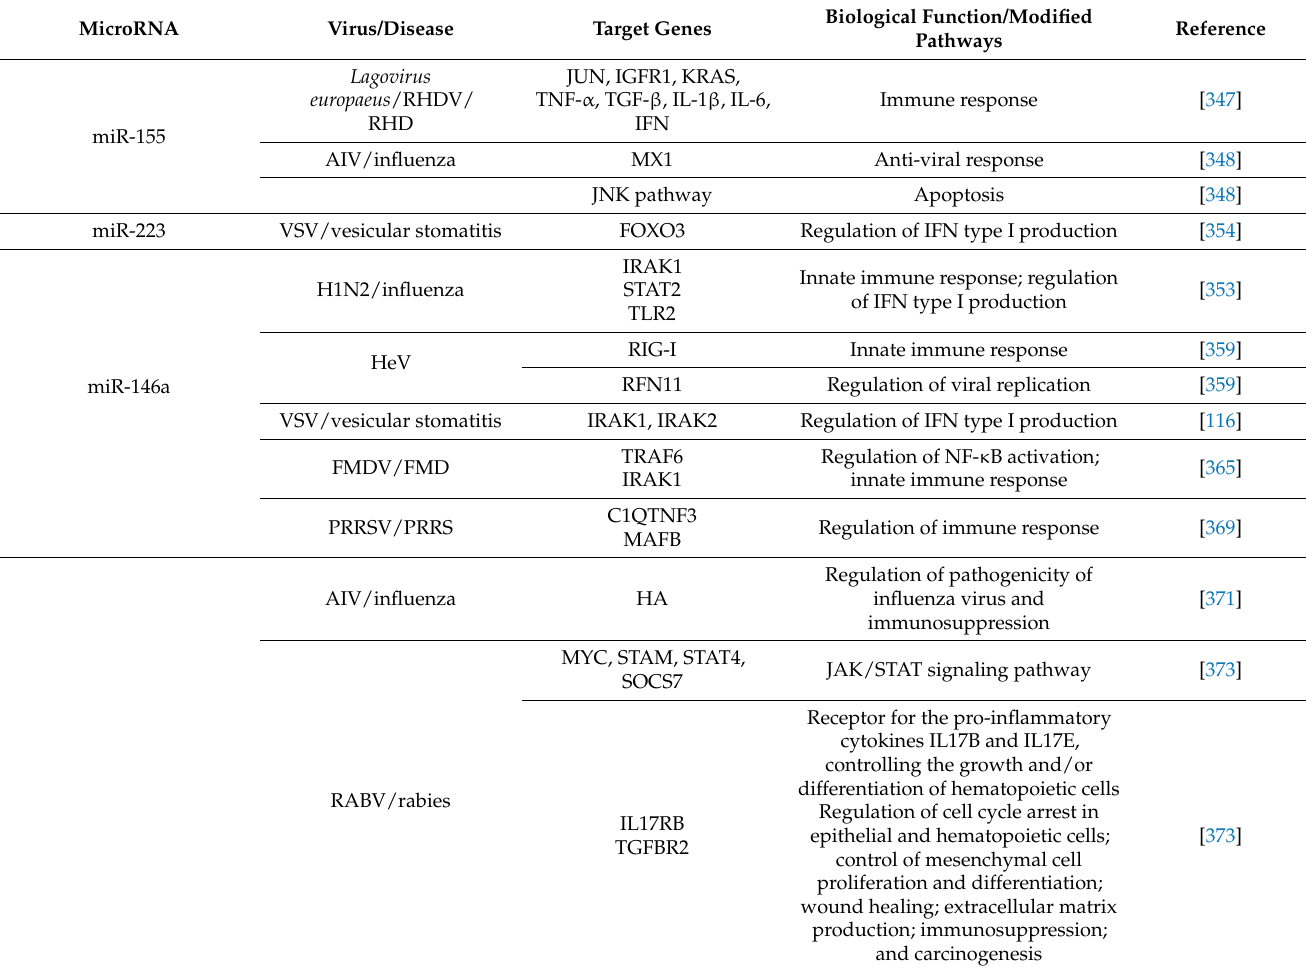
Table 2. MicroRNAs that are important in animal viral